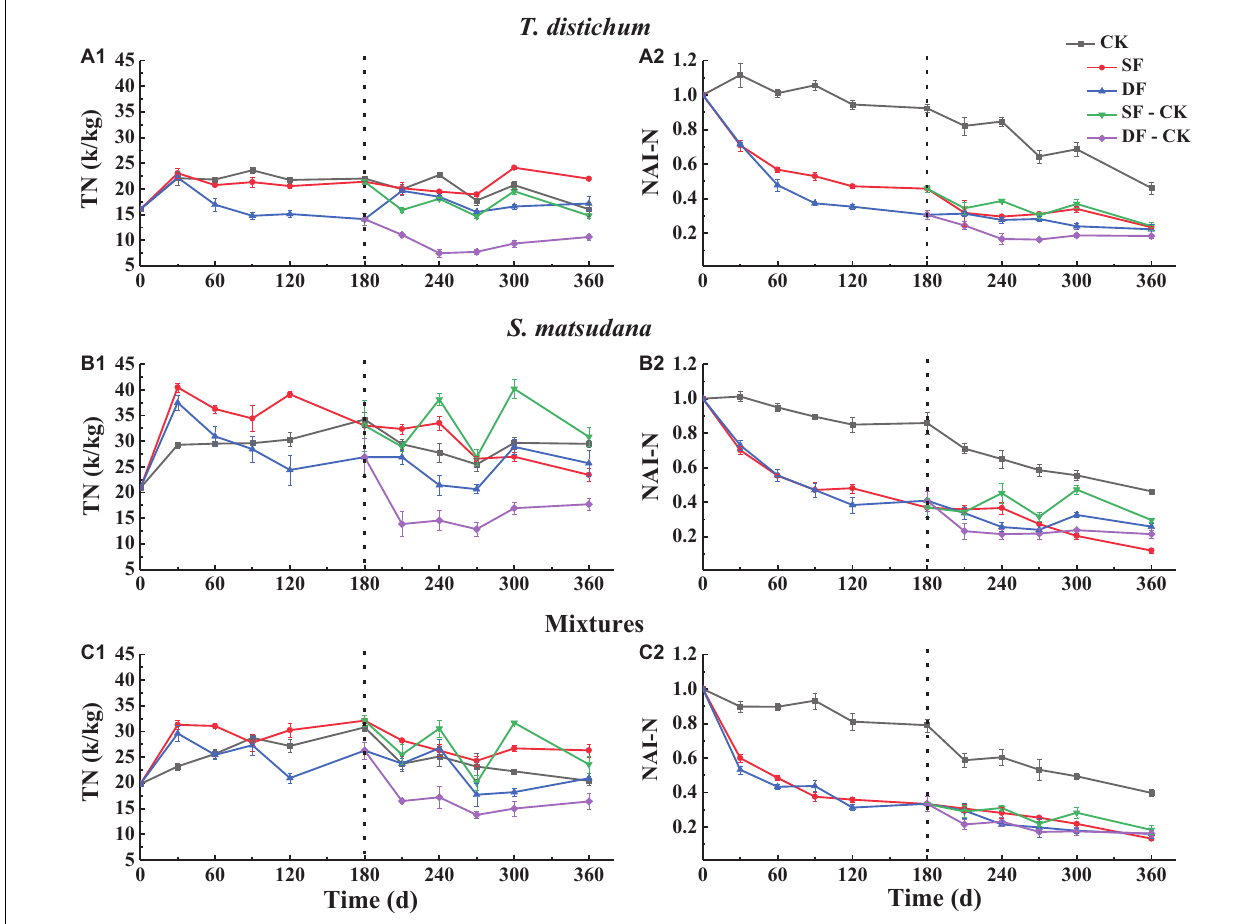
FIGURE 4 | The variation of total nitrogen concentration (A1–C1) and NAI-N index (A2–C2) during the process of foliage decomposition. CK, unflooded; SF, shallow flooding; DF, deep flooding; SF-CK, first half a year SF followed by half a year CK; DF-CK, first half a year DF followed by half a year